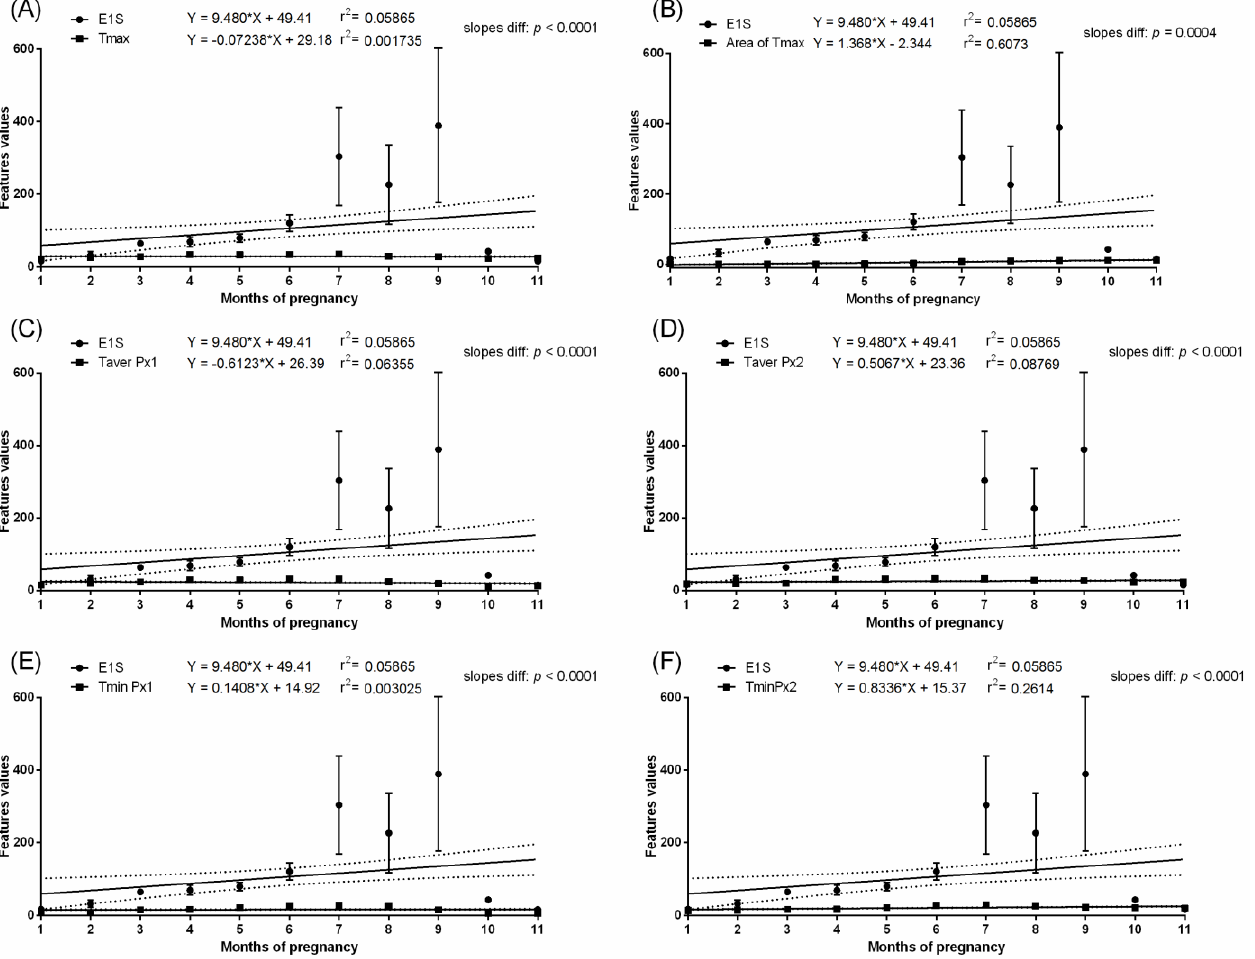
Figure 3. Linear regressions of estrone sulfate concentration in the serum and selected thermal features of the lateral surface of the abdomen in pregnant mares: the maximal temperature in Px1 and Px2 ( A ); the area with the highest temperatures in the range of 3 ◦ C ( B ); the average temperature in Px1 ( C ); the average temperature in Px2 ( D ); the minimal temperature in Px1 ( E ); the minimal temperature in Px2 ( F ).